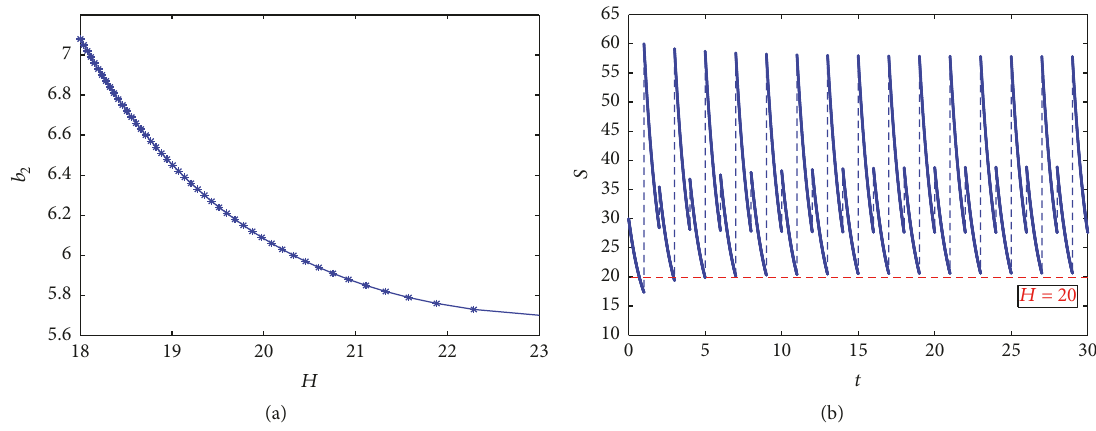
Figure 6: (a) The value of 𝑏 2 for 𝐻 ∈ (18, 23) ; (b) the solution of (39) with 𝑏 = 6 and the initial point (0, 30)